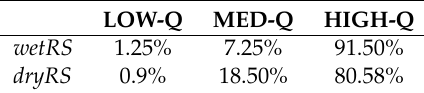
Table 4. Quality detection with the proposed method in databases composed of EEG segments collected during a resting state task ( wetRS and dryRS denote the databases acquired with the standard wet EEG electrodes, and dry EEG sensors, respectively). The values indicate the percentage of detected segments in each class (LOW-Q, MED-Q and HIGH-Q).